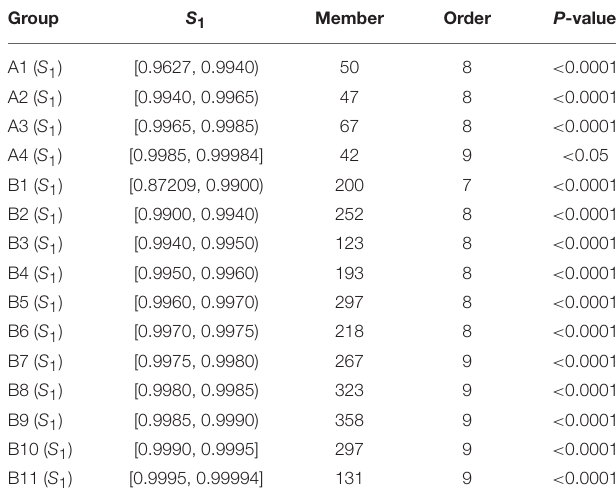
TABLE 1 | Extent of strand symmetry determined by word symmetry distance analysis ( WSD 2 and nWSD 2) in groups of archaeal and bacterial genomes classified according to their GC content.